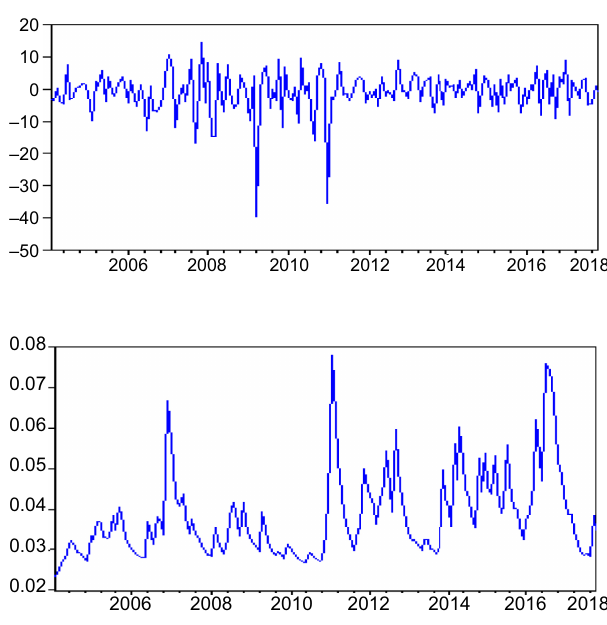
Figure 3. Tunindex